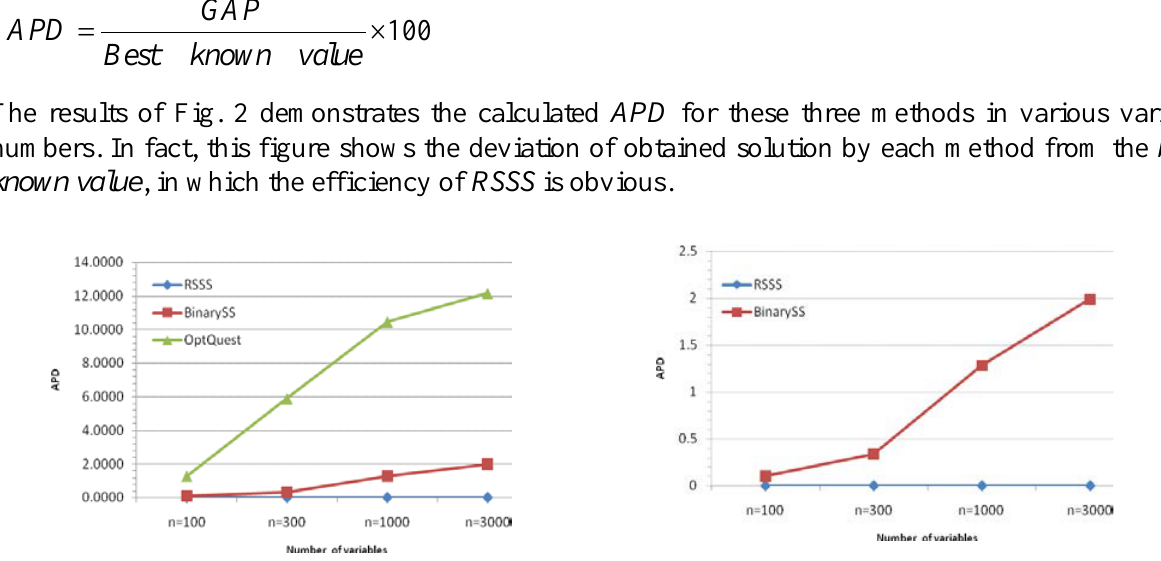
Fig. 2. The value of APD for each number of